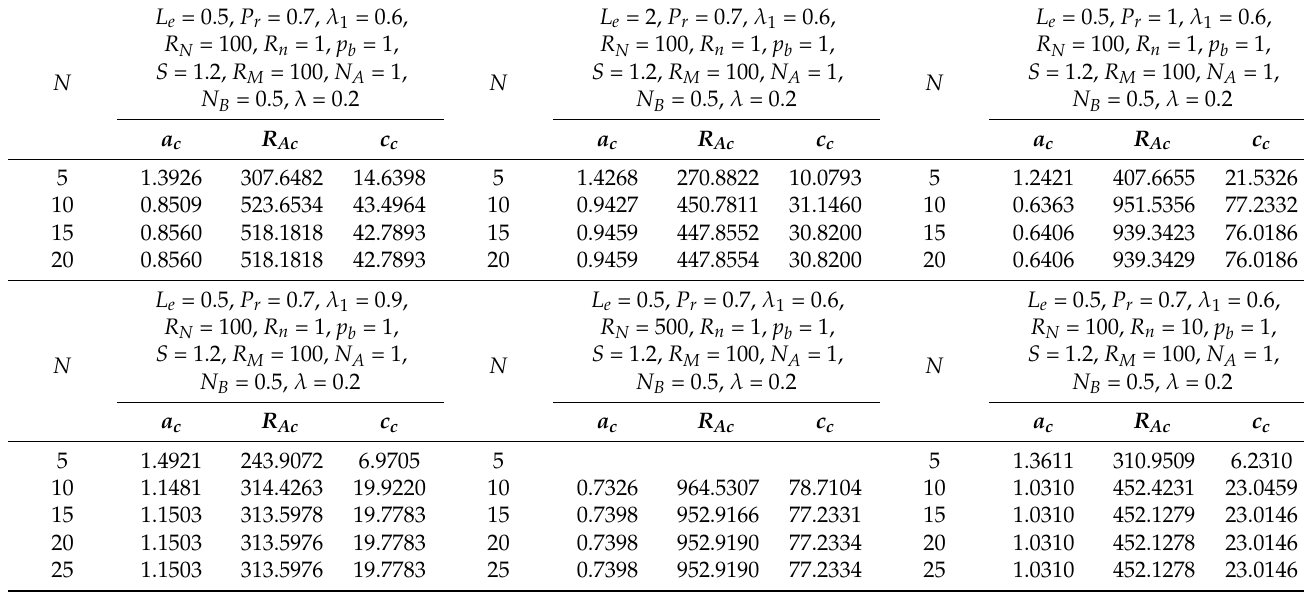
Table 1. The effect of the various governing parameters on the critical thermal Rayleigh number R Ac , the critical wavenumber a c and the critical wave speed c c obtained by the numerical solution of Equations (29)–(32). N is the number of terms in the expansions (35) for R Ac , a c and c c to